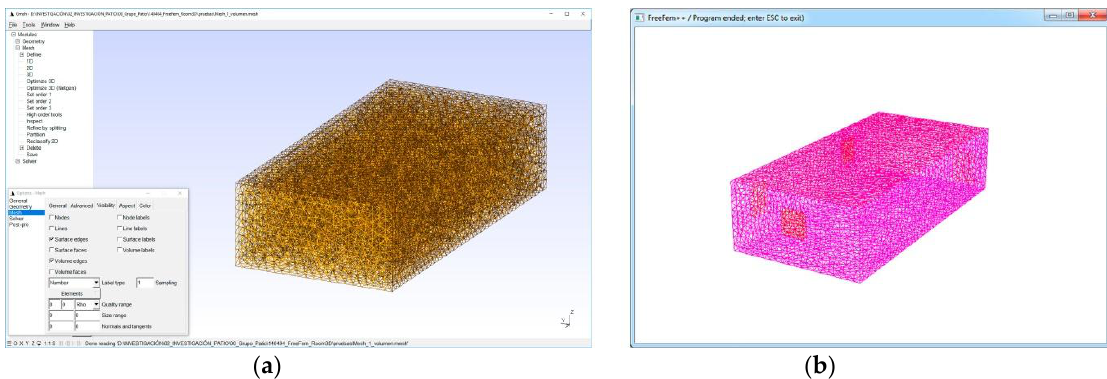
Figure 4. Mesh exported from GMESH to FreeFem++, ( a ) general mesh and ( b) volume with windows.